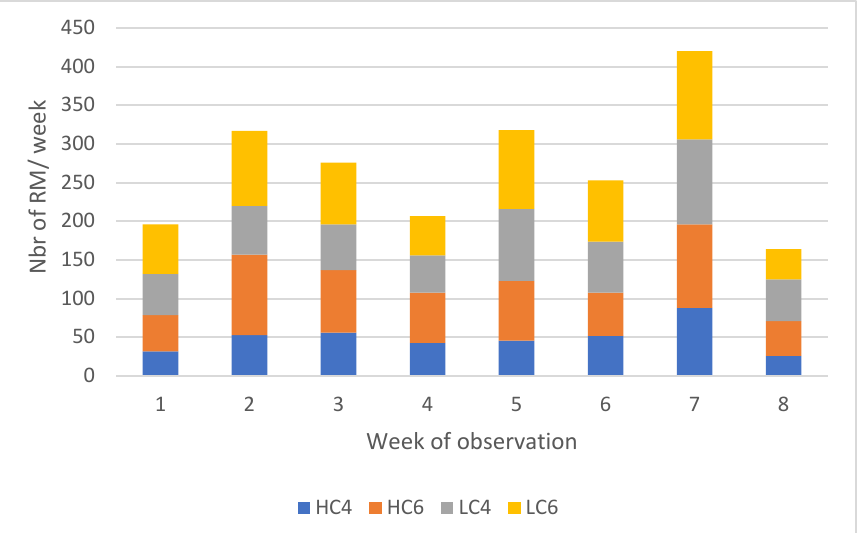
Figure 5. Relative occurrence of refused milkings (RM) of the different groups over the weeks of observation. Abbreviations. HC4, High concentrate allocation, MMI set at 4 h. HC6, High concentrate allocation, MMI set at 6 h. LC4, Low concentrate allocation, MMI set at 4 h. LC6, Low concentrate allocation, MMI set at 6 h.